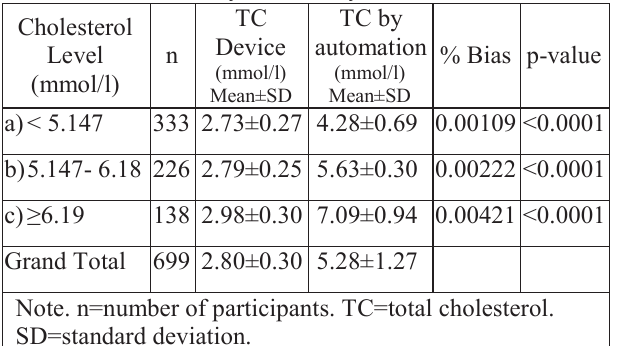
Table-3: Comparison of Device versus laboratory estimation according to Cholesterol Level